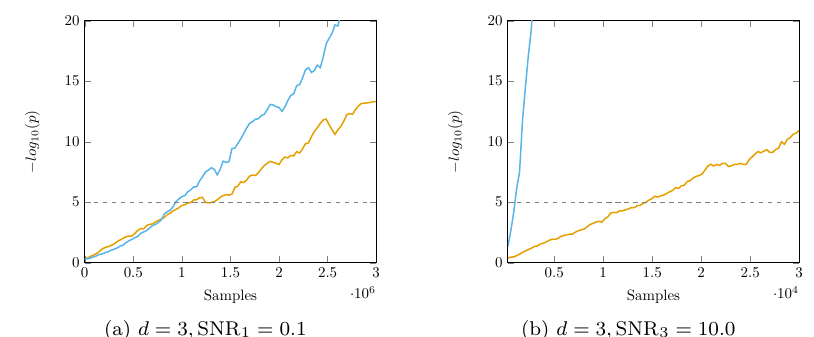
Figure 4: Performance of the (orange) t -test and (blue) χ 2 -test for simulated univariate 3rd-order leakage with SNR 1 = 0 . 1 and SNR 3 = 10 .